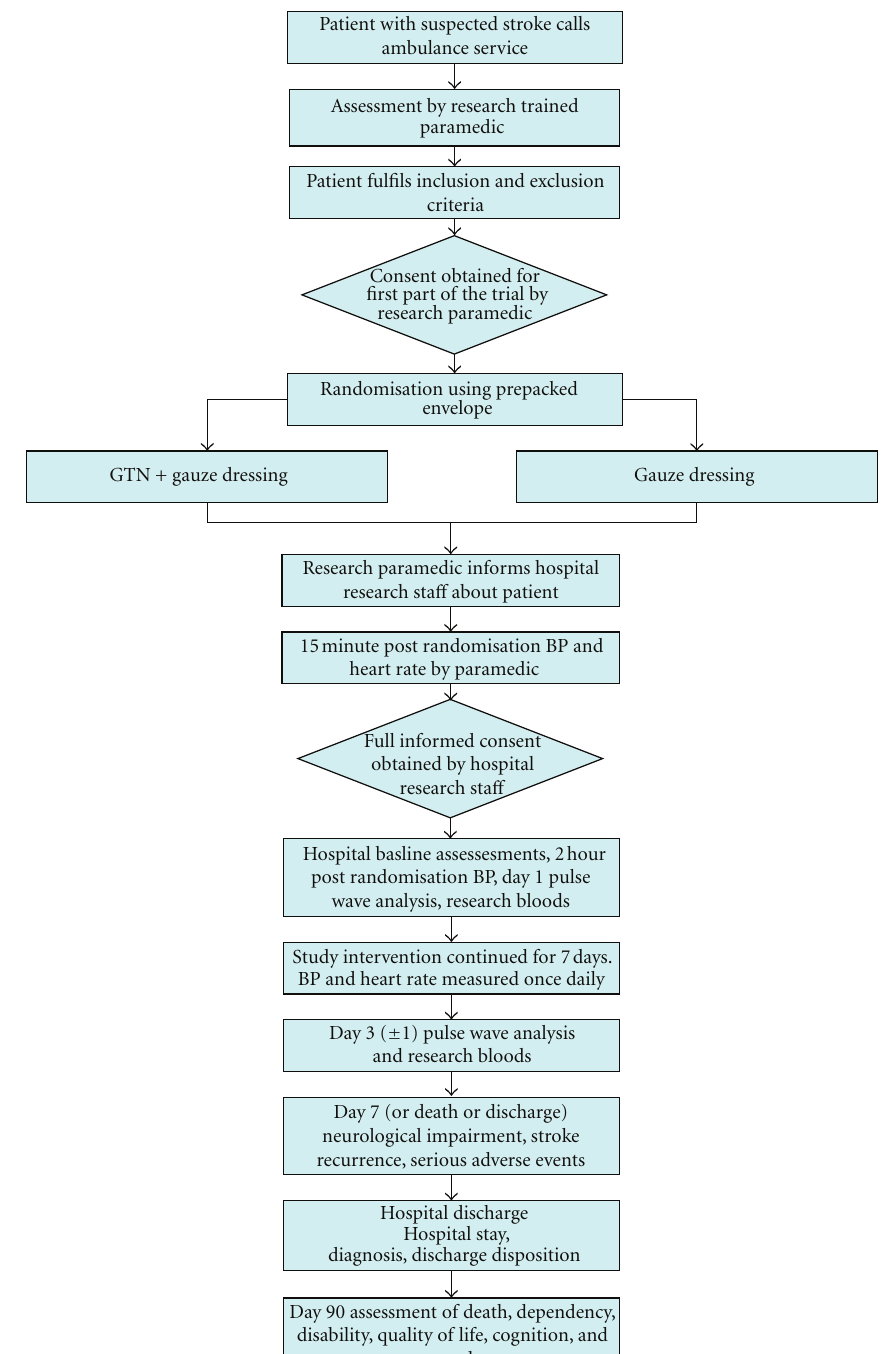
Figure 1: Trial flow